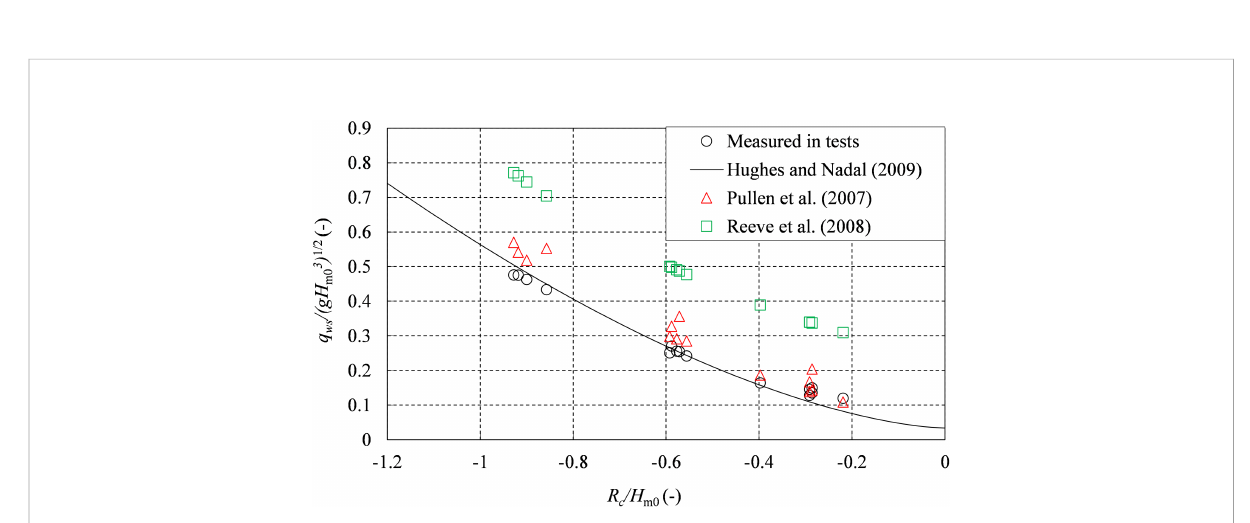
FIGURE 5 Dimensionless average discharge versus relative